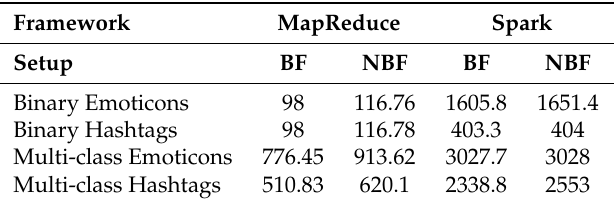
Table 5. Space compression of feature vectors (in